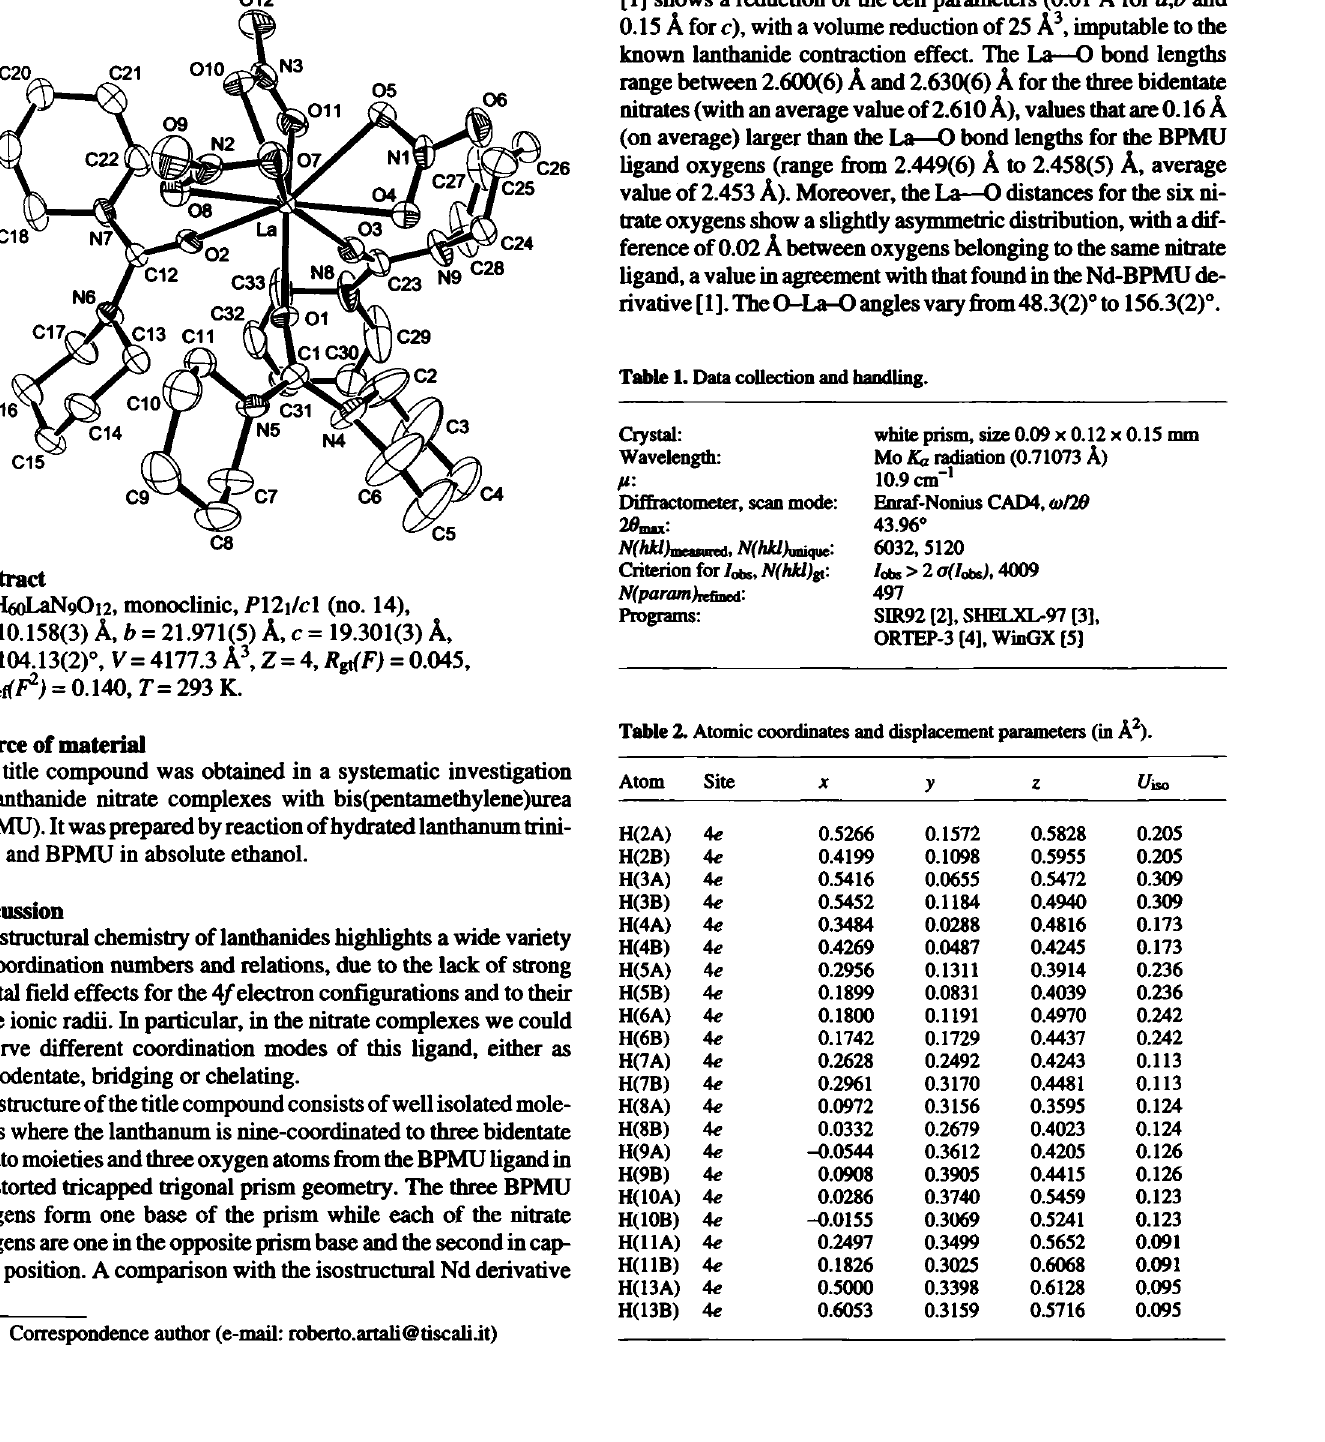
Table 1. Data collection and handling.